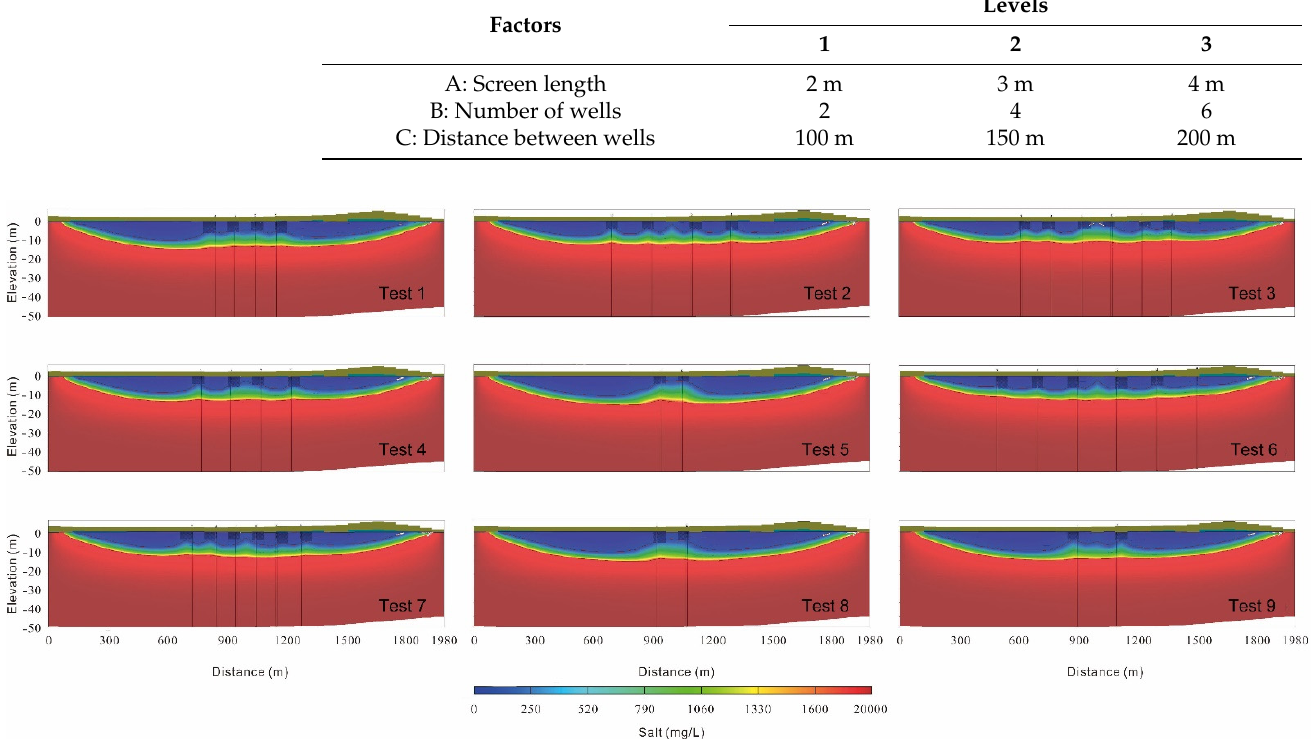
Figure 5. Distribution of salinity in cross-section of different experimental scenarios.